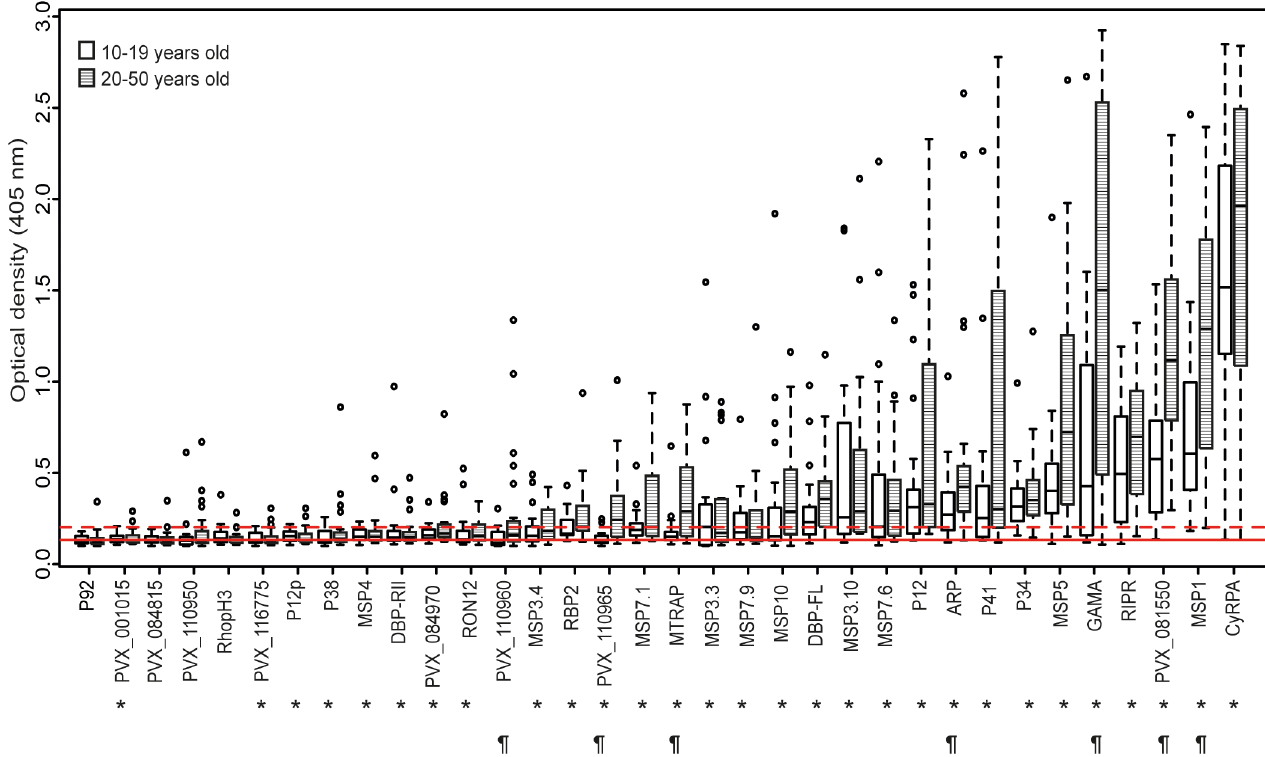
Fig 1. IgG reactivity to 34 P . vivax merozoite proteins in Solomon Islanders. Boxplots show median optical density (horizontal bar), interquartile range (boxes), range (whiskers), and outliers (open circles). Antibodies to the Cd4-tag are represented as mean (solid red line) and mean + 2 standard deviations (dashed red line). Clear boxes represent adolescents (10 – 19 years; n = 22;) and striped boxes represent adults (20 – 50 years; n = 24). Asterisks indicate 29/34 proteins for which the population mean antibody level was significantly higher than to Cd4 alone. ¶ symbols indicate 7/34 proteins for which IgG levels differed significantly between adolescents and adults. P values are from Mann-Whitney U tests and were deemed significant if < 0.05.